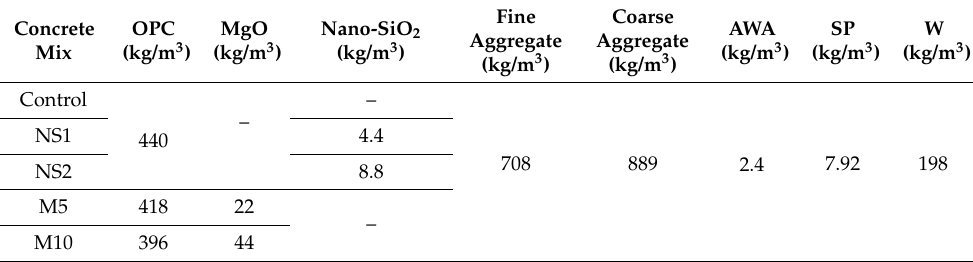
Table 1. Concrete mix